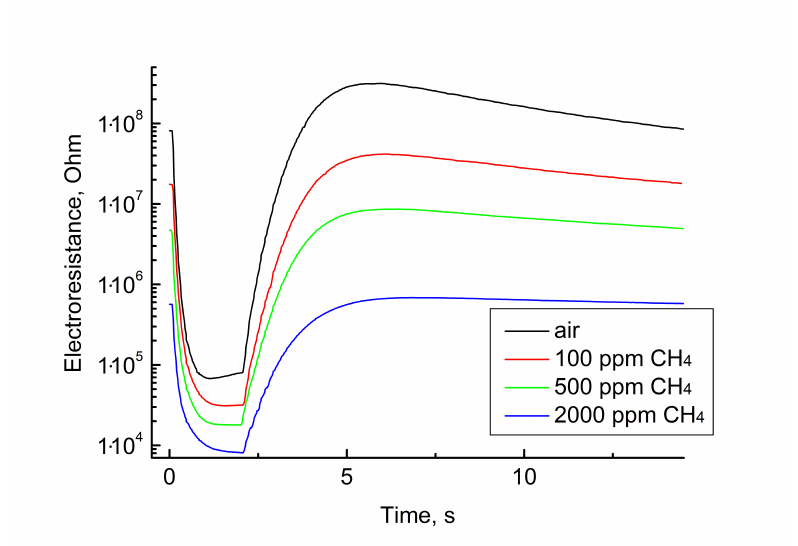
Figure 7. Electrical resistance of the sensor as a function of time during one cycle of measurements at determining different CH 4 concentrations.